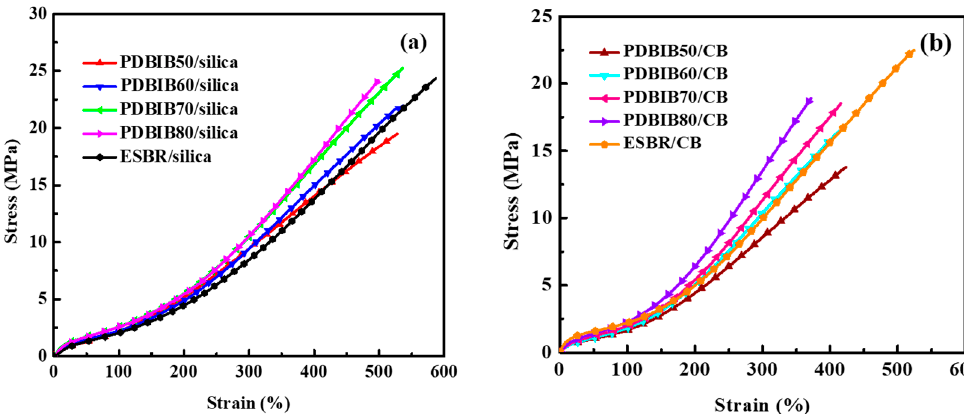
Figure 5. Stress–strain curves for PDBIB and ESBR nanocomposites ( a ) PDBIB / silica and ESBR / silica; ( b ) PDBIB / CB and ESBR / CB.